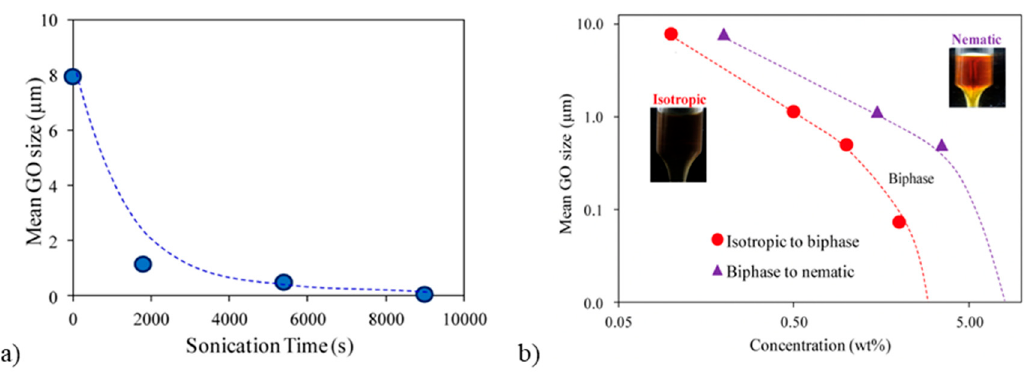
Figure 7. ( a ) Mean graphene oxide (GO) sheet size as a function of sonication time. ( b ) Comparison of isotropic to biphasic and biphasic to nematic phase boundaries of four different mean GO sheet sizes. Adapted and reprinted with permission from Ahmad, R.T.M.; Hong, S.-H.; Shen, T.-Z.; Song, J.-K. Optimization of particle size for high birefringence and fast switching time in electro-optical switching of graphene oxide dispersions. Opt. Express 2015, 23, 4435–4440 with the permission of AIP